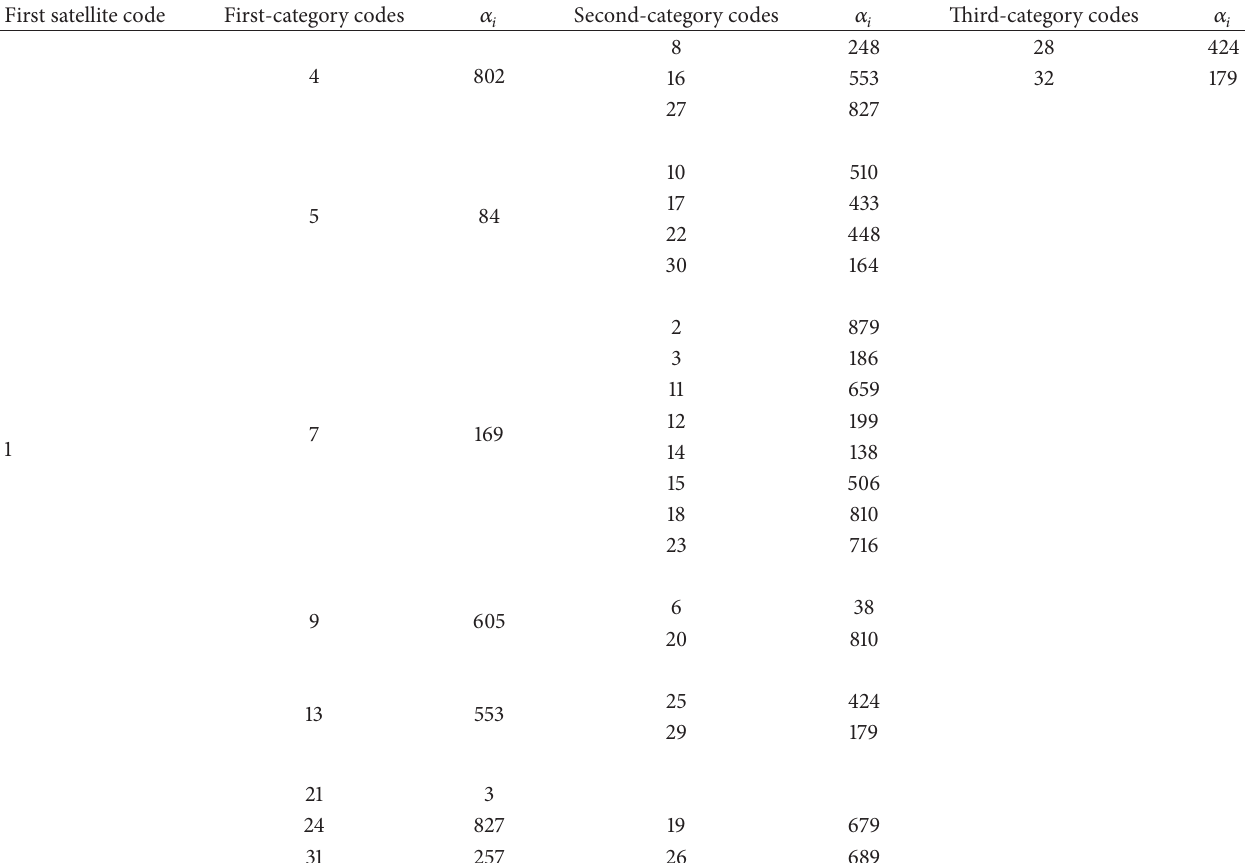
Table 2: Different categories of C/A-GPS Gold codes and their corresponding 𝛼 𝑖